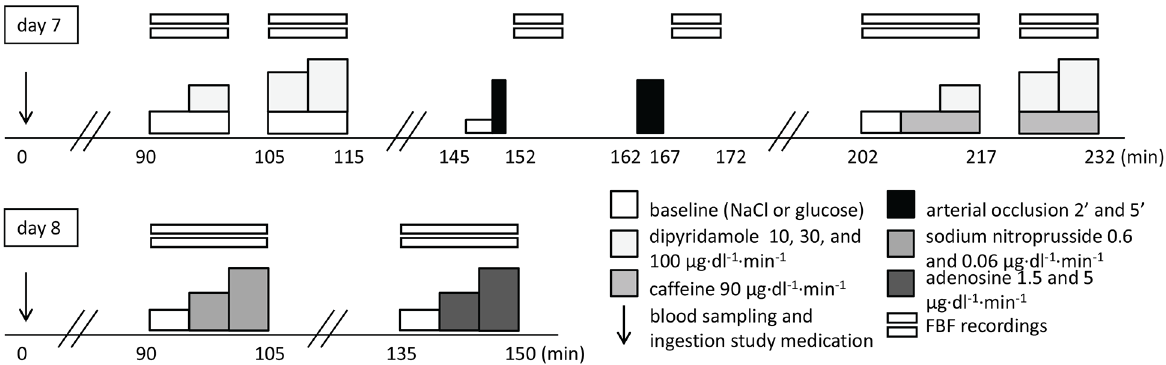
Figure 1. Schematic overview of the experimental protocol.